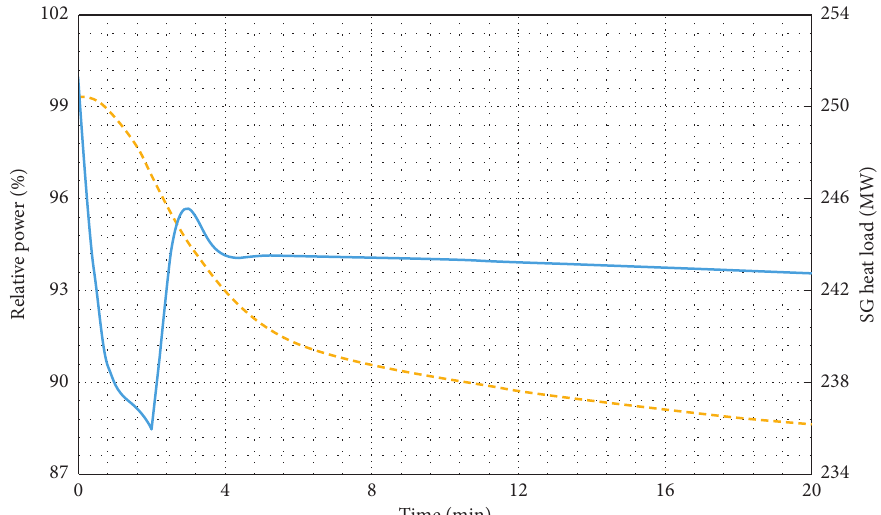
Figure 15: Relative power and SG heat load of #2 module in case 2 (solid line: relative power; dashed line: SG heat load).